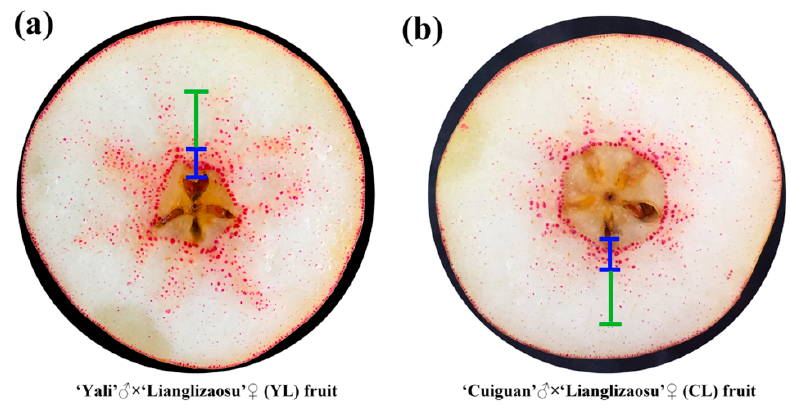
Figure 2. Distribution of stone cell clusters of ‘Yali’ ♂ × ‘Lianglizaosu’ ♀ (YL) and ‘Cuiguan’ ♂ × ‘Lianglizaosu’ ♀ (CL) fruit: ( a ) YL fruit; and, ( b ) CL fruit. The blue marked area is the inner flesh region, and the green marked area is the middle flesh region.